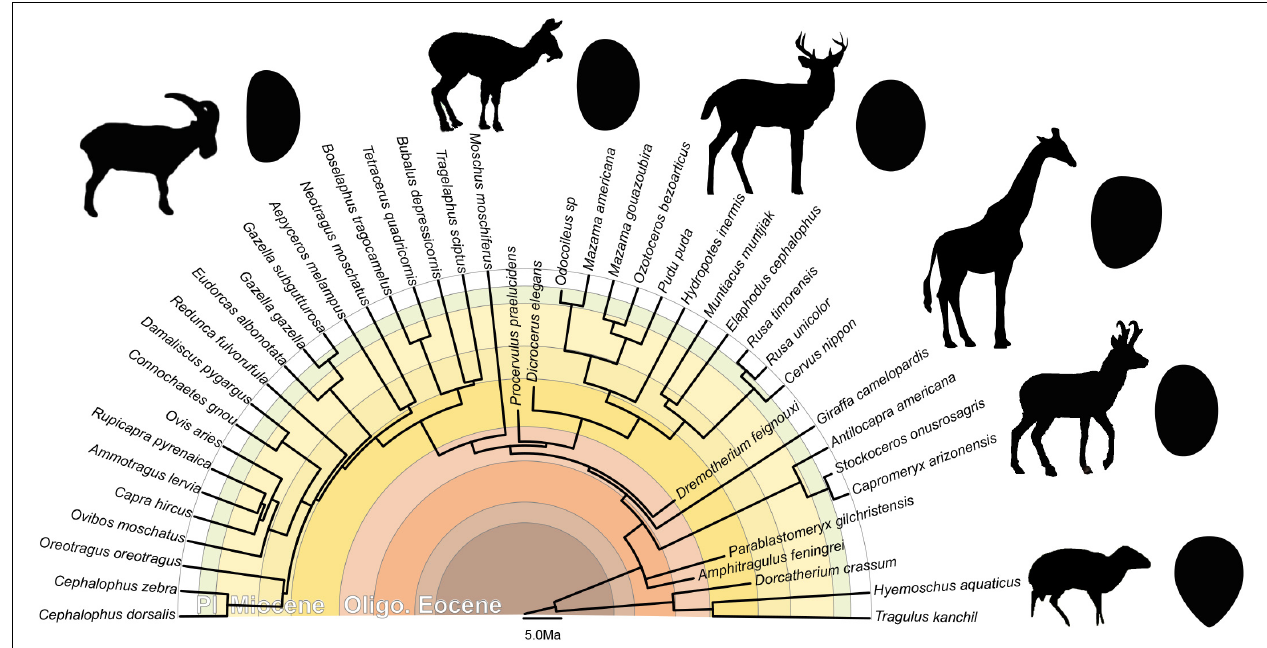
FIGURE 6 | Phylogeny of the studied ruminants with associated general stapedial footplate morphology. Topography of the tree based on (Janis et al., 1998; Hassanin et al., 2012; Mennecart, 2012; and Mennecart et al., 2019; calibration of the Cervidae nodes based on Mennecart et al., 2017; calibration of the Bovidae nodes based on Bibi, 2013). Oligo.: Oligocene; Pl.: Pliocene.